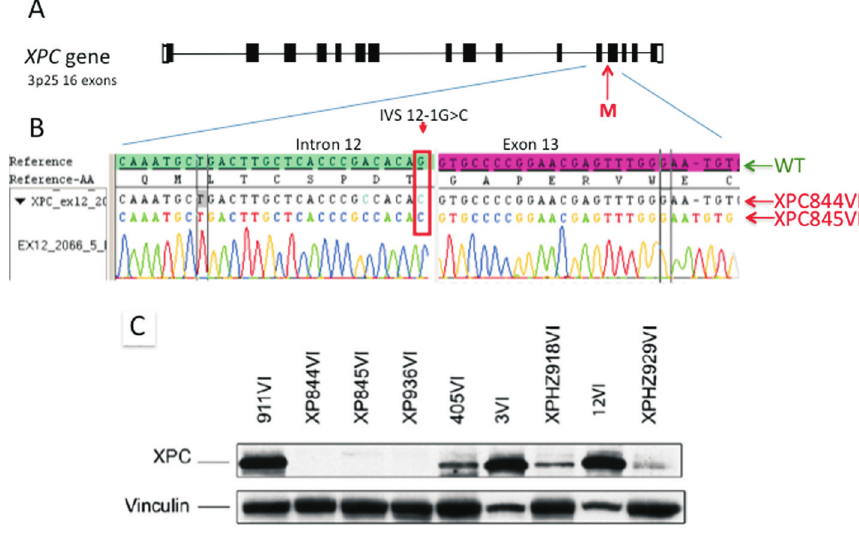
Figure 3 - Point mutation in the XPC gene of all Comorian XP-C patients. A) The XPC gene is located on 3p25 and composed of 16 exons. B) The muta- tion(M),aGtoC,islocatedonthesplicingsiteonthelast3’nucleotideofintron12.Thewildtypesequenceofintron12isindicatedingreenandtwopa- tient (XP844VI and XP845VI) sequences are given below. C) Represents a Western blot of the XPC protein in diploid skin fibroblasts. XP844VI, XP845VI and XP936VI correspond to three XP-C patients with no detectable XPC protein. XPHZ918VI and XPHZ929VI correspond to two heterozy- gousXP-CparentswithabouthalfofthenormalamountoftheXPCprotein.ThenormalrangeoftheXPCproteinisgivenwiththefourotherlanescorre- sponding to various wild type fibroblasts. Vinculin is shown as a marker of protein loading. (Adapted from Cartault et al. , 2011).